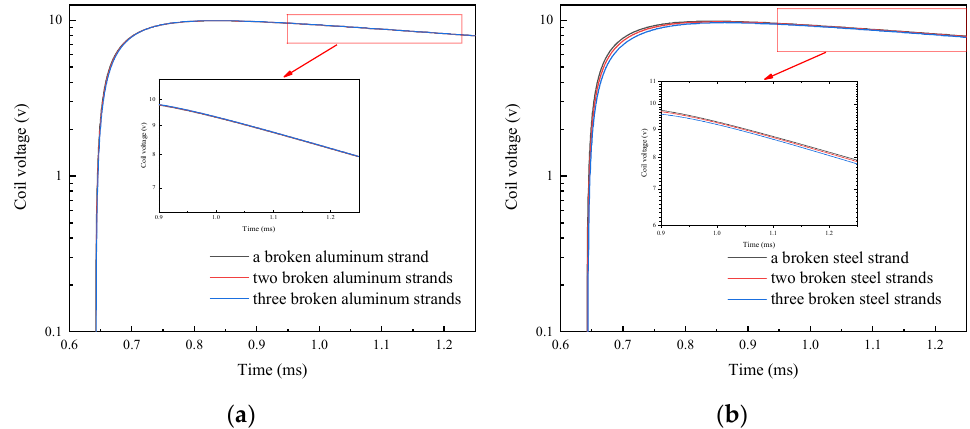
Figure 6. The signals of the broken strands by the slope in the log scale under different conditions: ( a ) broken aluminum strands; ( b ) broken steel strands.